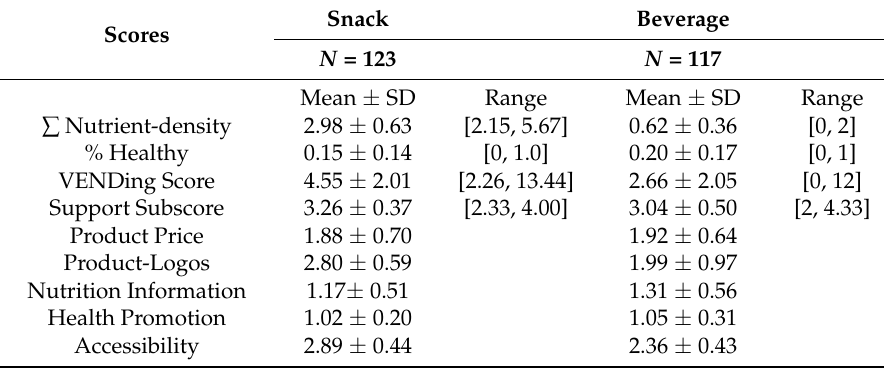
Table 4. VENDing score